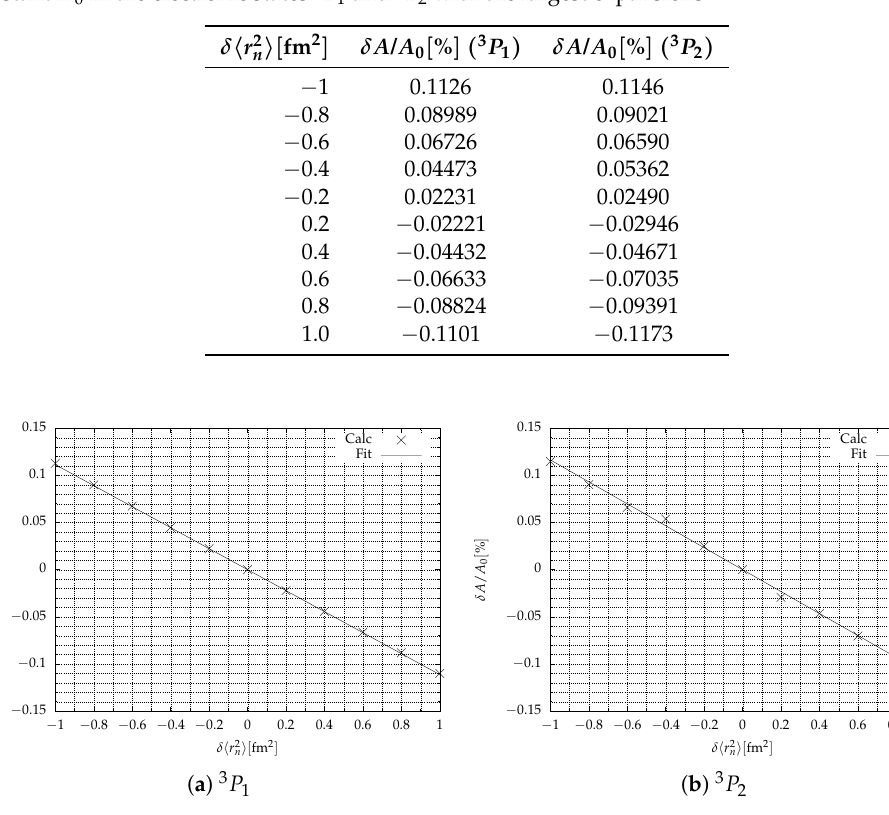
Figure 3. Relative change in the hyperfine structure constant δ A / A 0 with variation in the mean squared radius of the nuclear charge distribution δ (cid:104) r 2 n (cid:105) from the reference nucleus with hyperfine structure constant A 0 in the electronic states 3 P 1 and 3 P 2 with the largest expansions. The solid line represents the linear fit λδ (cid:104) r 2 n (cid:105) . Table 7. Relative change in the hyperfine structure constant δ A / A 0 with variation in the mean squared radius of the nuclear charge distribution δ (cid:104) r 2 n (cid:105) from the reference nucleus with hyperfine structure constant A 0 in the electronic states 3 P 1 and 3 P 2 with the minimal